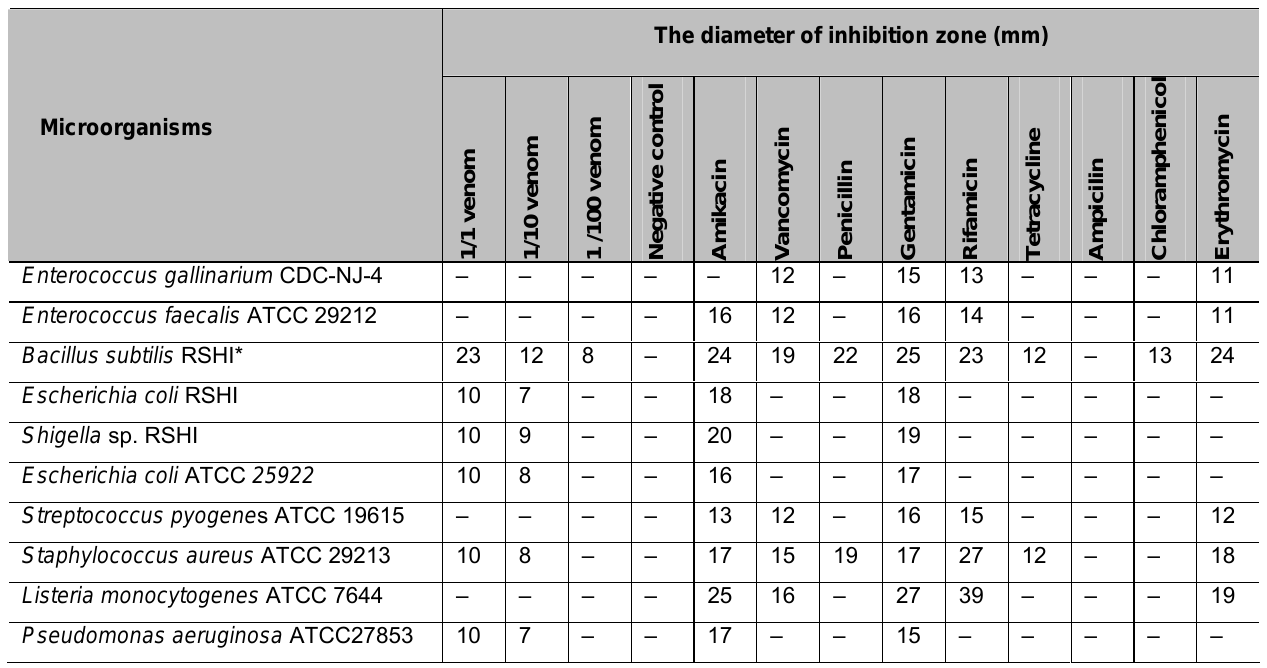
Table 1. The inhibition zones were formed by three different concentrations of venom, negative control and some standard antibiotics. *RSHI: Microbiology Laboratory Culture Collection of Refik Saydam Hifzissihha Institute, (-): No inhibition zone